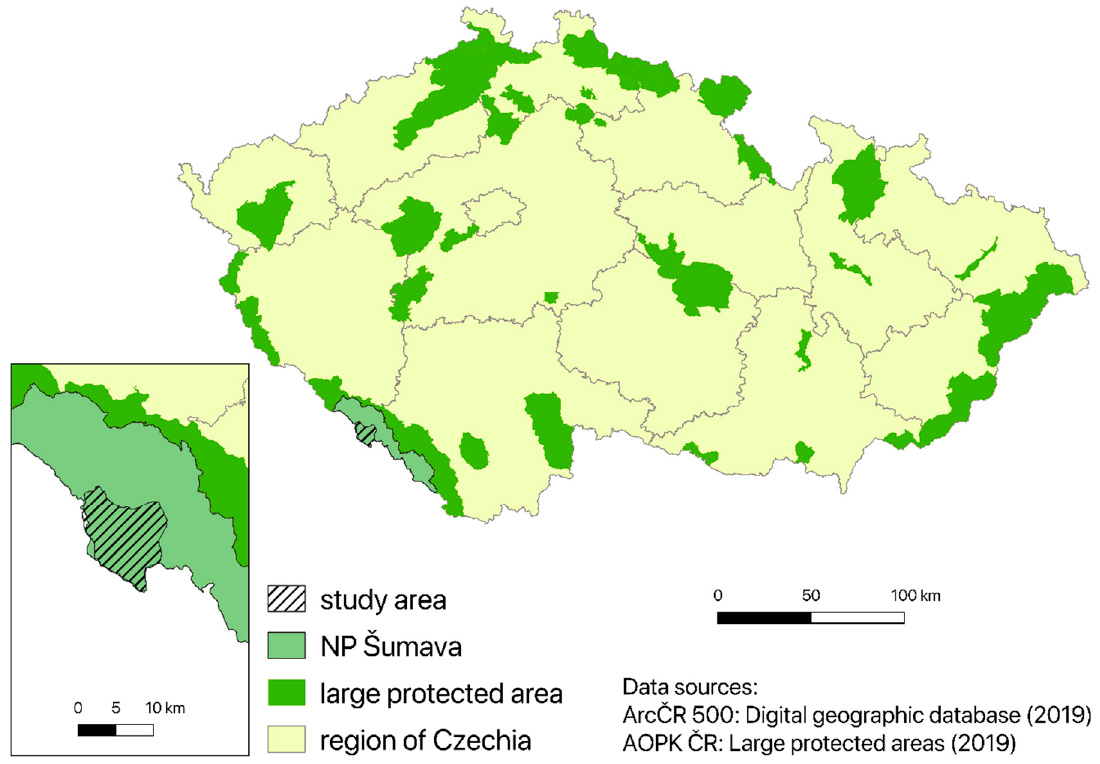
Figure 1. Study area.